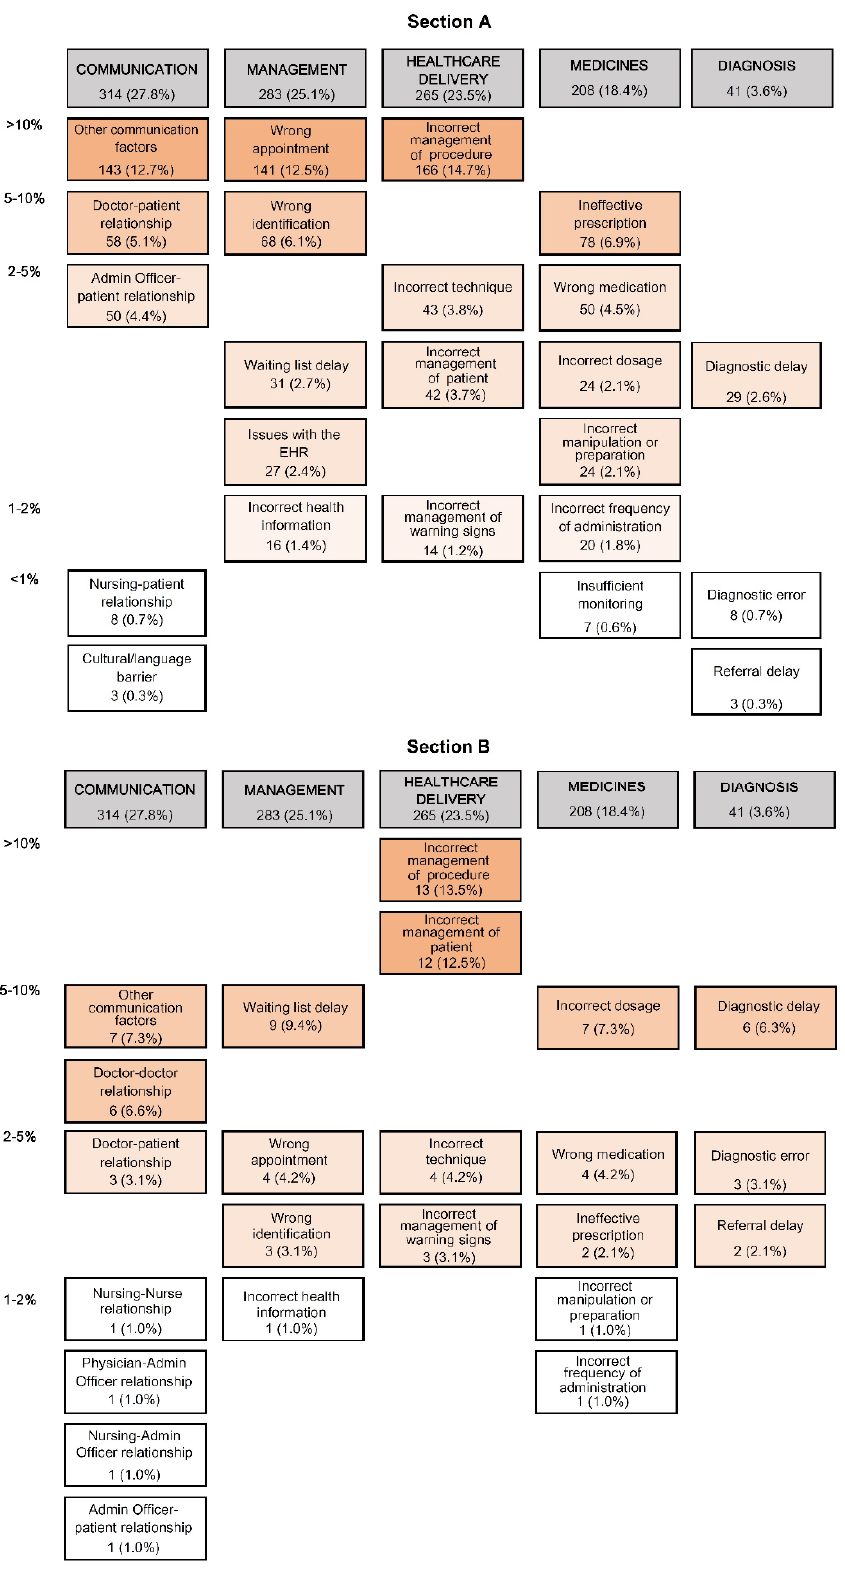
Figure 3. Risk map of the causal factors of the patient safety incidents. The figure shows the causal factors according to the APEAS model of the total patient safety incidents notified (section A; n = 1129) and adverse events notified (section B; n = 96) [19].